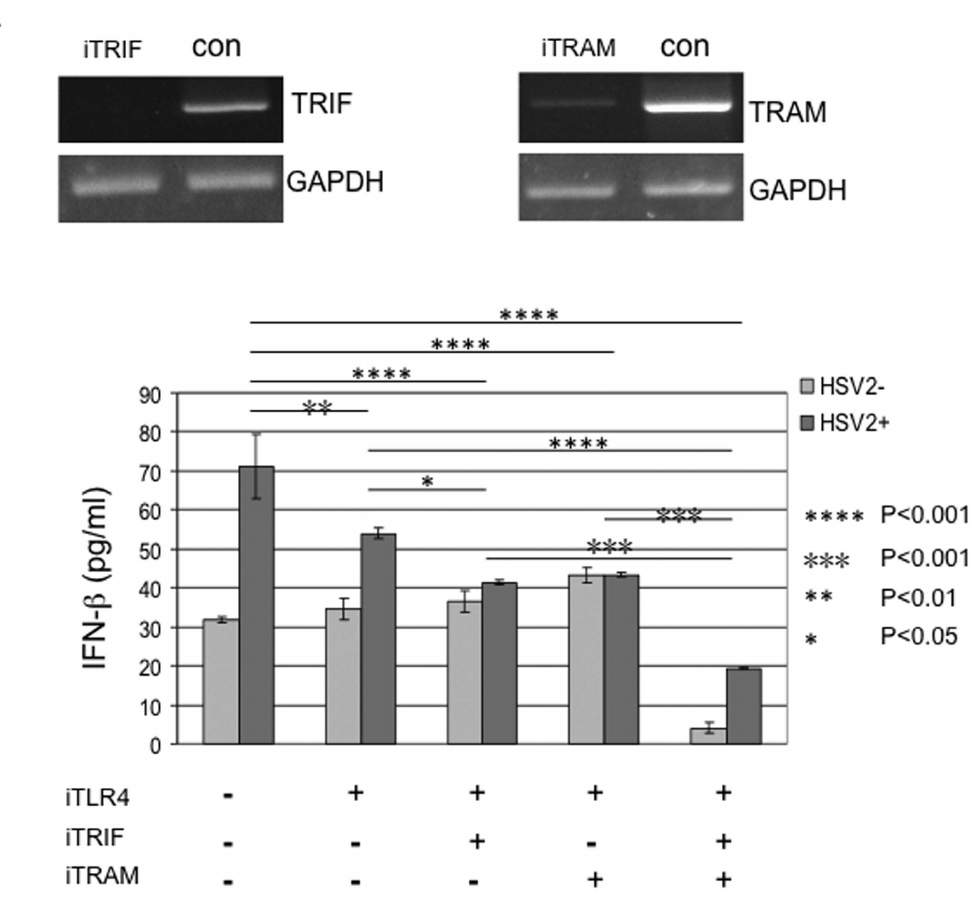
Figure 4. TRIF and TRAM are involved in HSV-2 induced TLR4-dependent production of IFN- b . (A) Confirmation of knockdown of TRIF and TRAM. HCE cells were transfected with scrambled siRNA control or siRNA-TRIF (refer to iTRIF) or siRNA-TRAM (refer to iTRAM). Forty-eight hours after transfection, total RNAs were collected and the expression of TRIF and TRAM was analyzed by RT-PCR. The expression of GAPDH was used as the internal control. The experiment was repeated three times, the representative images from one experiment are shown. (B) HCE cells were transfected with negative control siRNA duplexes or iTLR4 or iTRIF and iTRAM or iTRIF/iTRAM together with iTLR4. At 48 h after transfection, HCE cells were infected with HSV-2 at 3 MOI or mock-infected. Cell-free supernatants were collected at 6 h post-infection for measurement of IFN- b secretion by ELISA analysis. Each assay was performed in triplicate. Results are reported as means 6 SD. * indicates p , 0.05, ** indicates p , 0.01, *** and **** indicates p , 0.001.